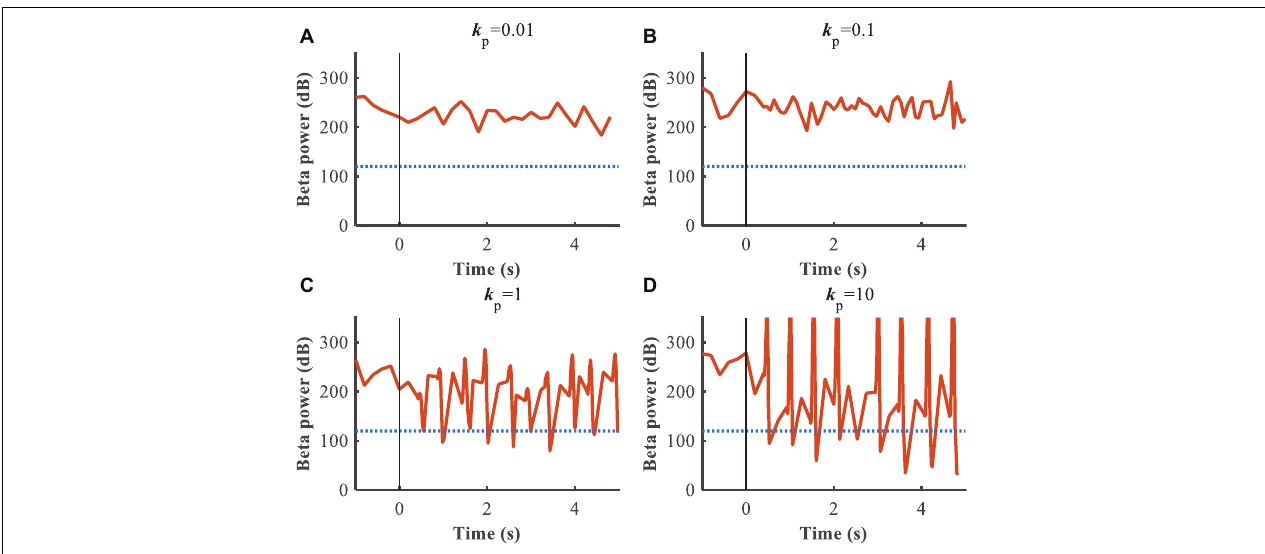
FIGURE 7 | Control effect of P controller with beta power as the feedback signal. Blue dotted lines represent the desired GPi beta power that recorded from healthy state, and orange traces represent feedback GPi beta power from the controlled state. Black solid lines denote the beginning of stimulation. (A) k p = 0 . 01, (B) k p = 0 . 1, (C) k p = 1, (D) k p =